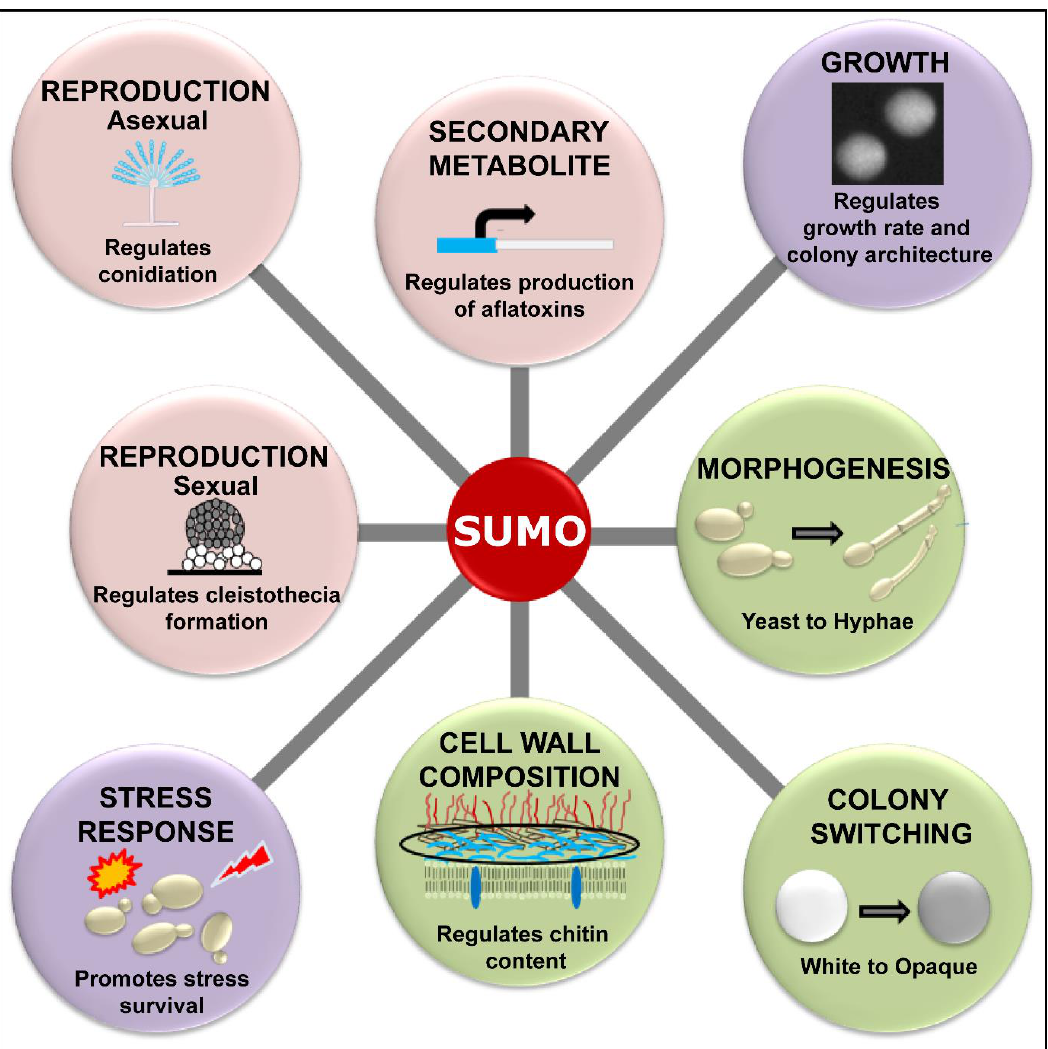
Figure 2. Schematic representation of diverse physiological processes, that are known to be regulated by SUMOylation in the human pathogenic fungi. SUMOylation regulates growth profiles and survival of different stresses in species of both Aspergillus and Candida . Additionally, while SUMOylation modulates sexual and asexual reproduction, and secondary metabolite production in Aspergillus , it regulates colony and morphology switching, and maintenance of cell wall composition in Candida .